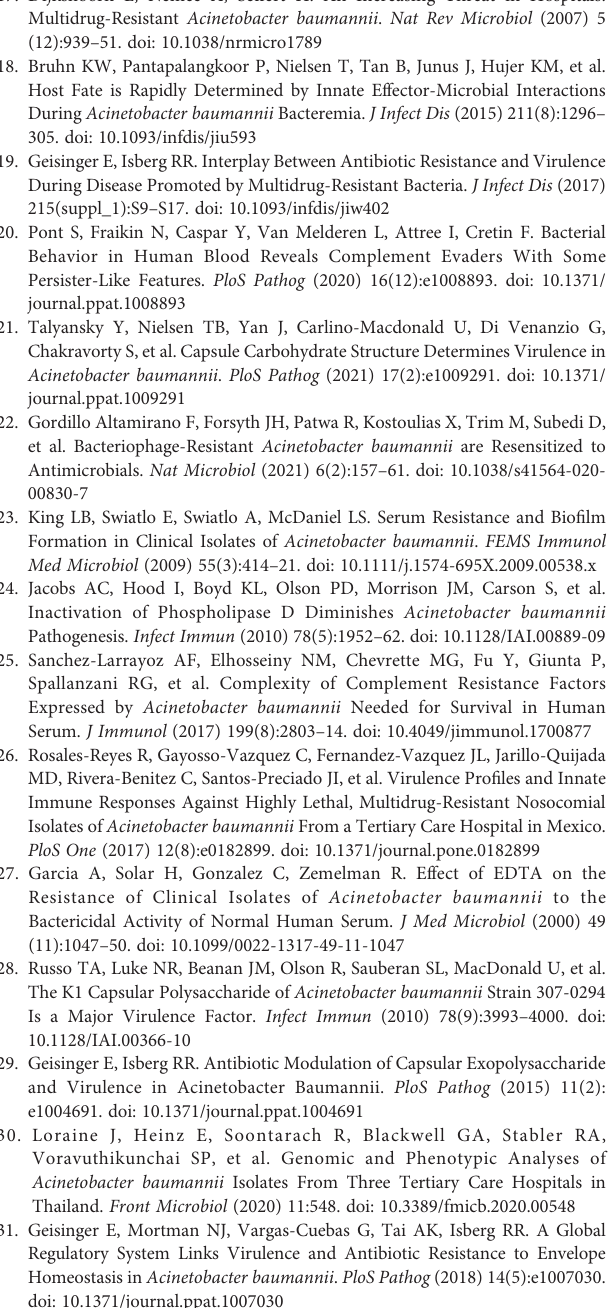
Supplementary Figure 1 | A. baumannii capsule inhibits complement- mediated bacterial lysis in the laboratory AB5075 strain. 10 4 CFU of the encapsulated laboratory AB5075 WT and the unencapsulated isogenic strains AB5075 D wza strain was incubated in either 50% NHS or HIS in triplicate and the viable bacterial counts determined by CFU counts after 14 hours of incubation. Bars represent mean values for each condition/strain and the error bars indicate standard deviations (SDs) (n=3). T-test was used for statistical analysis *: p-value < 0.05, **: p-value < 0.01, ***: p-value < 0.001, ****: p-value <0.0001 ns: p-value >